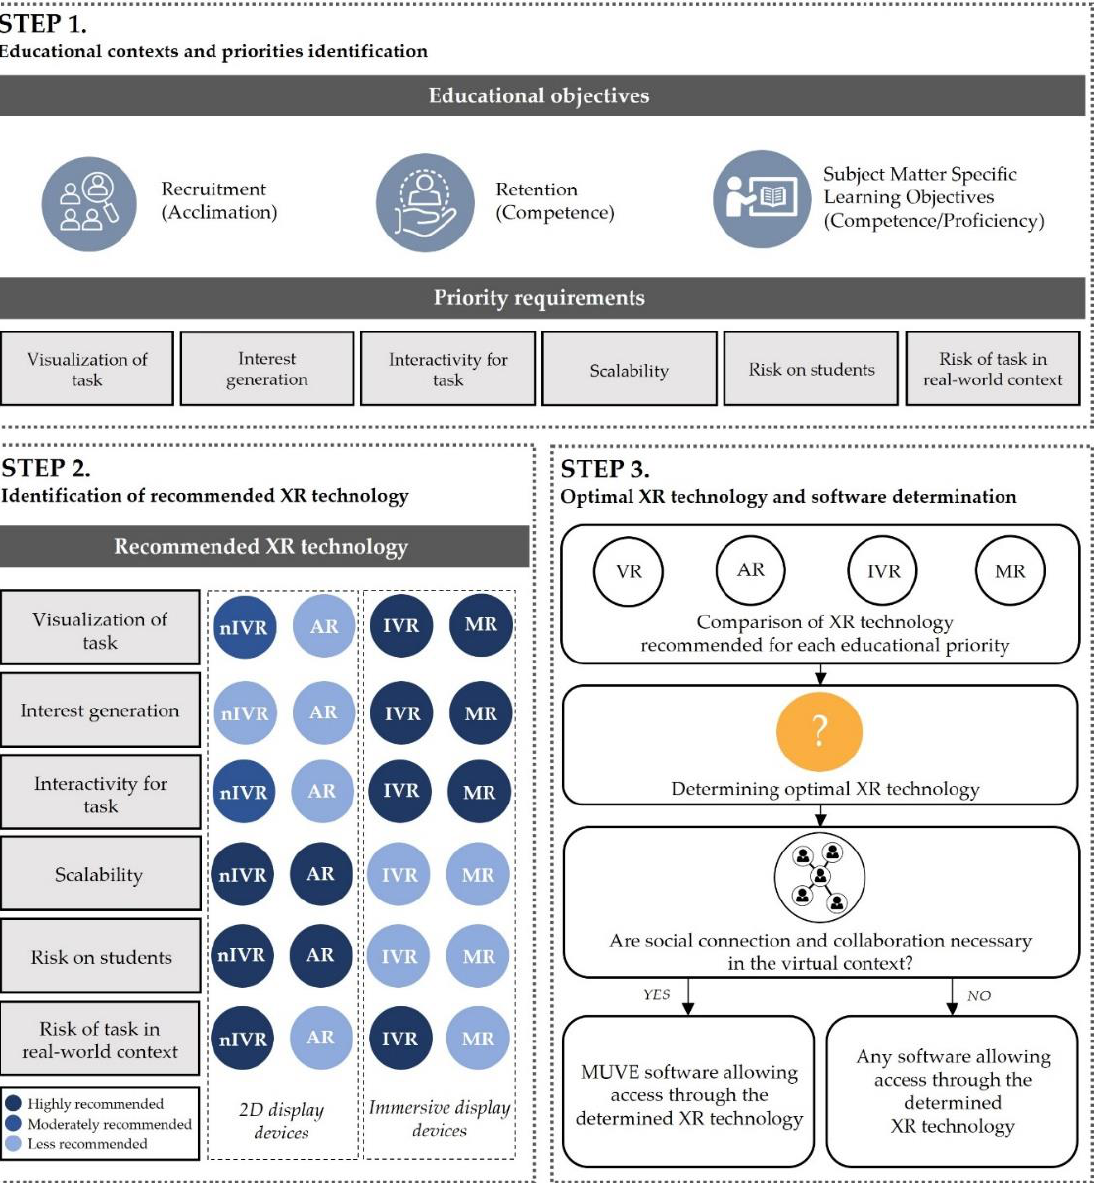
Figure 4. Decision- making framework guide for AE/C educators’ application of XR technologies. Figure 4. Decision-making framework guide for AE/C educators’ application of XR